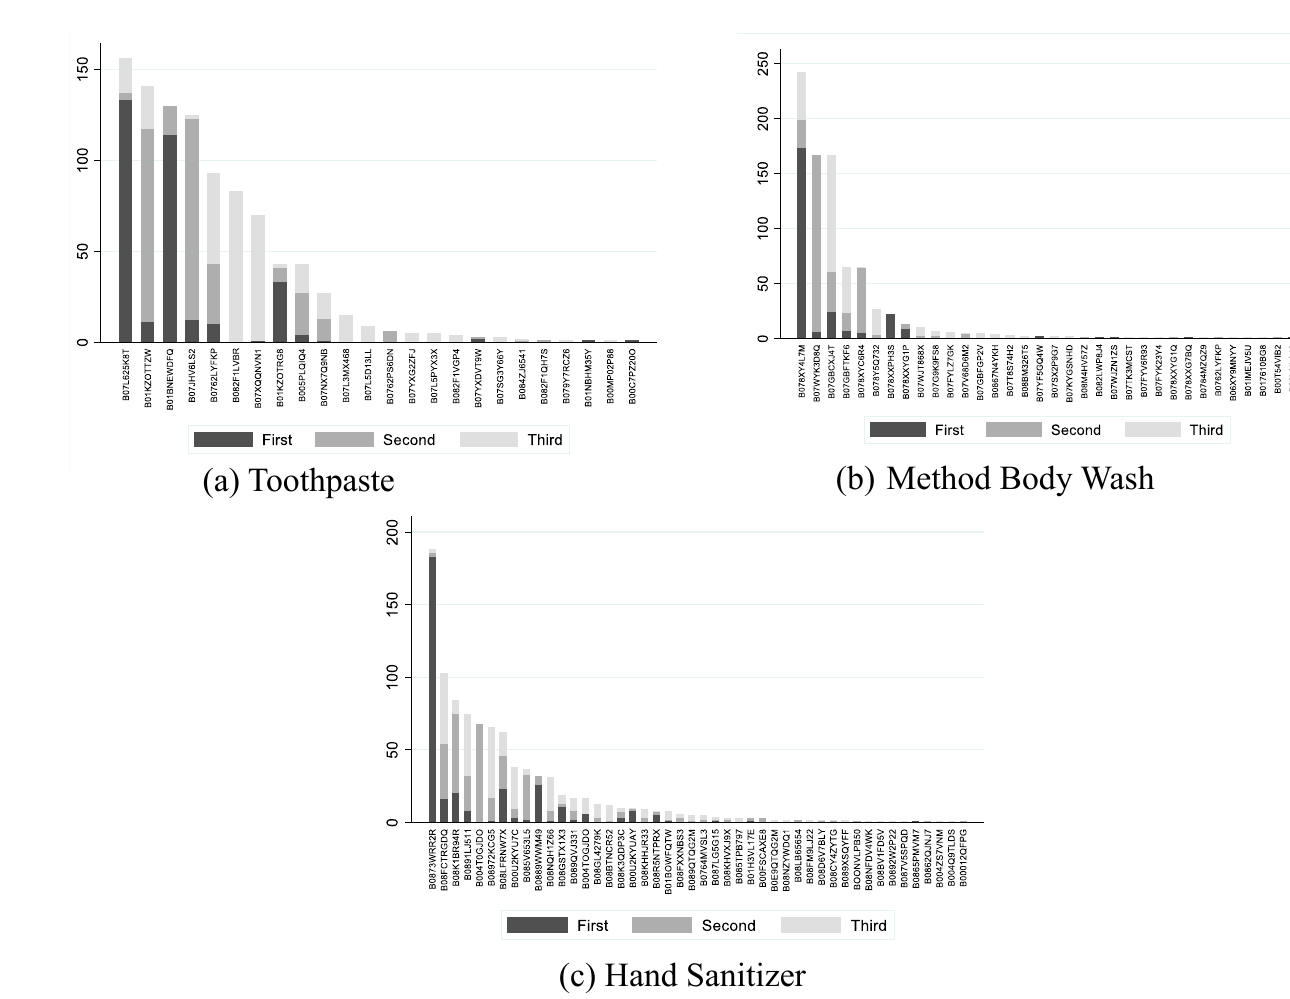
Figure 1. Frequency distribution of search results by ASIN.